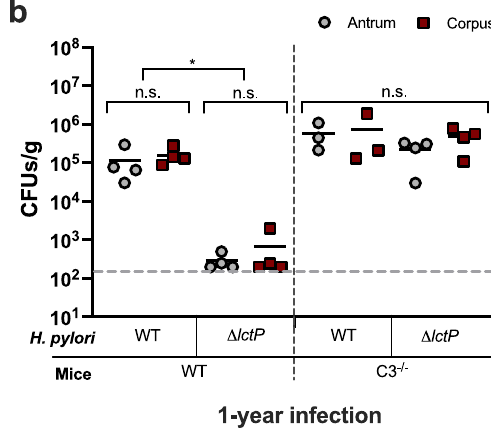
Fig. 5 | Loss of lctP renders H. pylori colonization de fi cient in a manner that is recovered by loss of complement. a Two-weeks infection by H. pylori strains. Group ofC57BL/6JWT( n =8) and isogenic C3 − / − ( n =8)micewere infected withthe H.pylori PMSS1WT;anothergroupofC57BL/6JWT( n =6)andisogenic C3 − / − ( n =6) mice were infected with the Δ lctP strain. b One-year infection by H. pylori strains. Group of C57BL/6J WT ( n =4)and isogenic C3 − / − ( n =3) mice wereinfected withthe H.pylori PMSS1WT;anothergroupofC57BL/6JWT( n =4)andisogenic C3 − / − ( n =4) mice were infected with the Δ lctP strain. The WT and C3 − / − mice were cohoused at